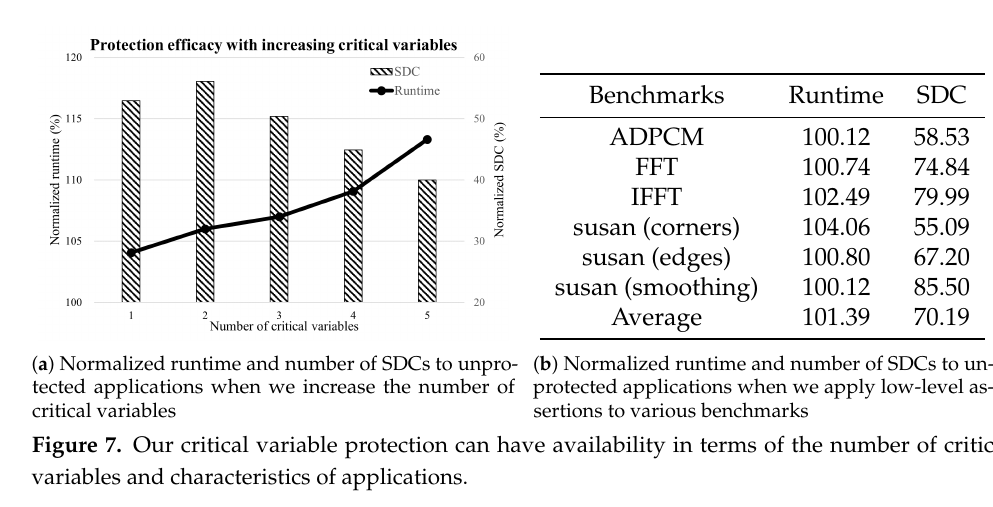
Figure 7. Our critical variable protection can have availability in terms of the number of critical variables and characteristics of